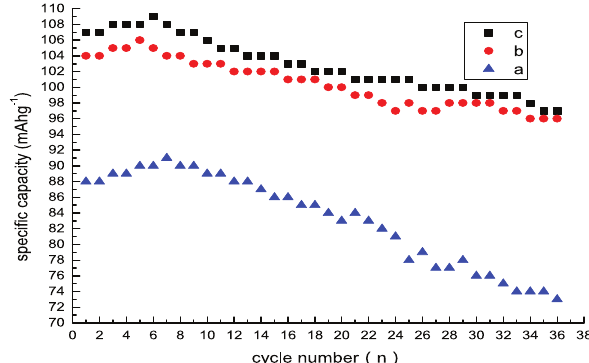
Fig. 5: Cycling curves of samples at 0.5C (a: 0 wt% carbon black coated, b: 2 wt% carbon black coated. c: 4 wt% carbon black